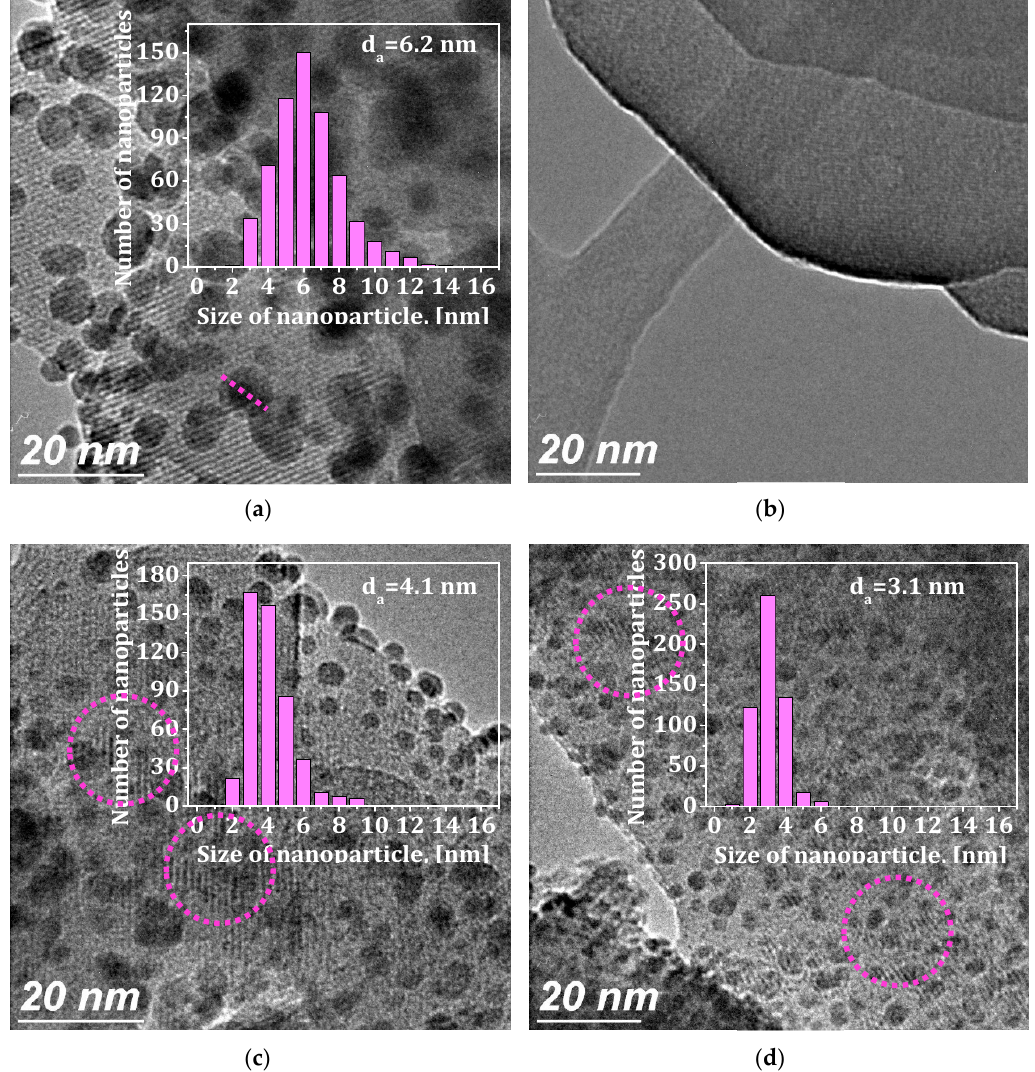
Figure 4. HRTEM-Micrographs and particle size distribution of the samples: ( a ) AgMORT 60 , ( b ) FeMORT 60 , ( c ) AgFeMORT 60 , and ( d ) mAgFeMORT 60 .